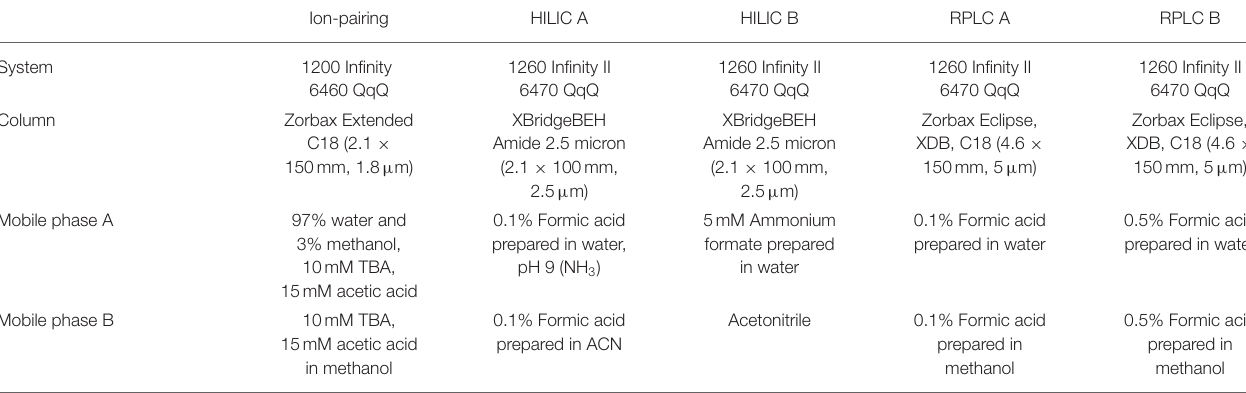
TABLE 1 | Corresponding systems, columns, and mobile phases of analytical methods developed in this